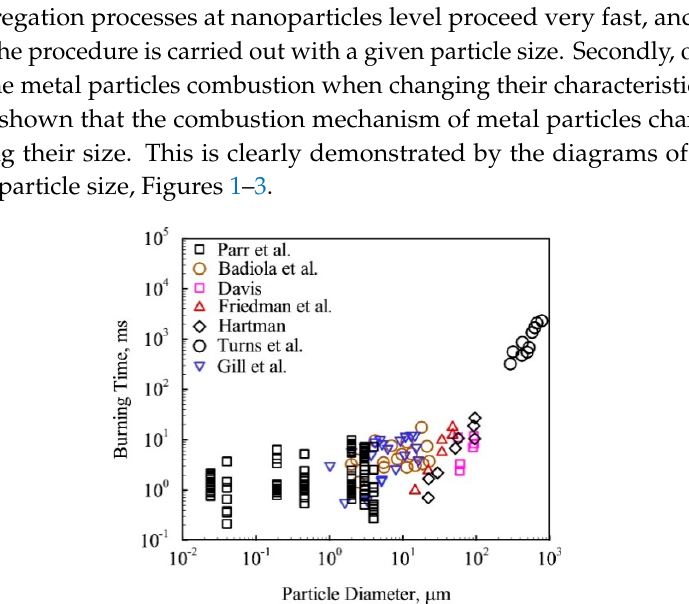
Figure 1. Burning time vs. aluminum particle size exhibiting weak size effect at nano-scales. Reproduced from [5], with permission from Prog. Energy Combust. Sci., 2017.